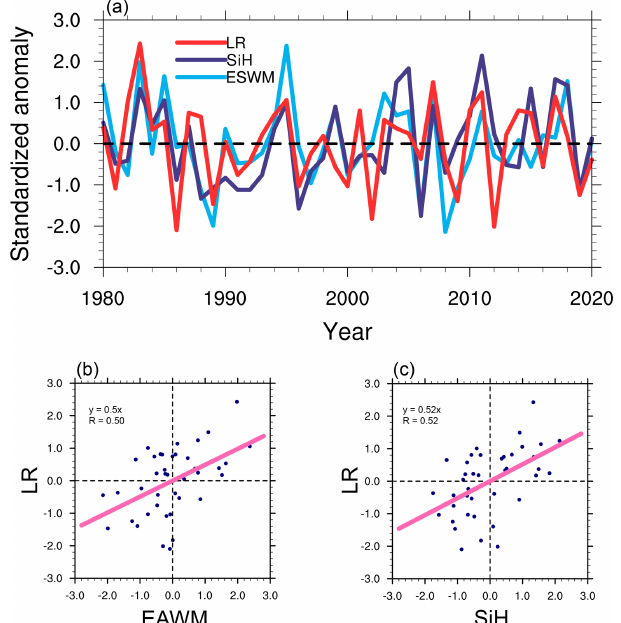
Figure 15. (a) Time series of the standardized anomaly of the win- tertime boundary layer lapse rate (LR) in domain d03 between 1000 and 850hPa, the index of the Siberian High (SiH), and the index of East Asian winter monsoon (EAWM) from 1980 to 2020. The scat- terplots of the correlations between (b) the standardized anomaly of the EAWM and LR and between (c) the standardized anomaly of the SiH and LR. The standardized anomaly is calculated by dividing anomalies by the climatological standard deviation.